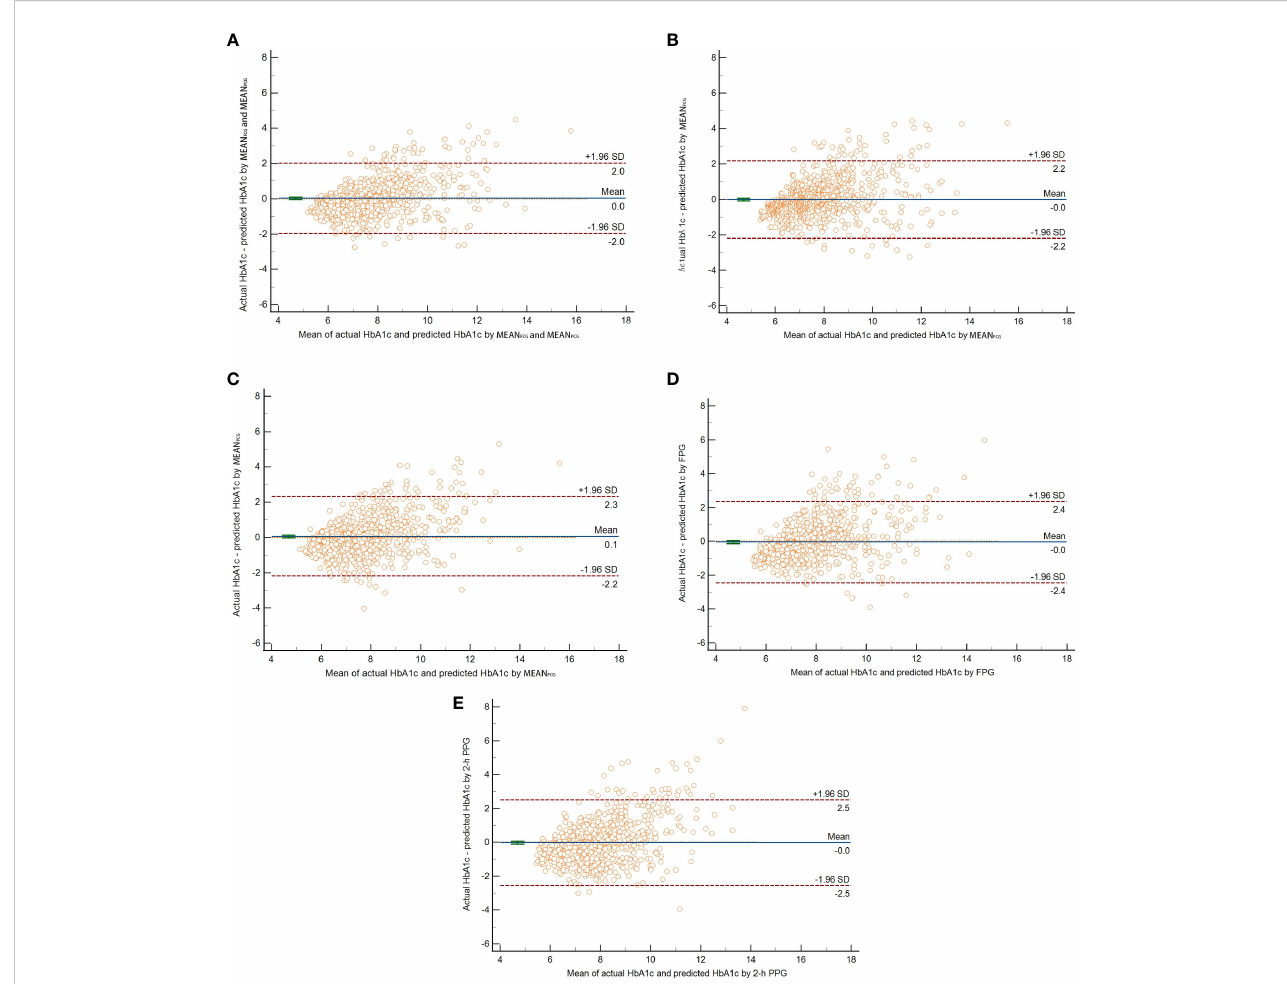
FIGURE 2 The Bland-Altman plot of actual HbA1c and predicted HbA1c by ridge regression with both MEAN FCG and MEAN PCG (A) , linear regression with MEAN FCG (B) , MEAN PCG (C) , FPG (D) , or 2-h PPG (E) respectively. The horizontal solid line in the middle indicated the mean difference between actual HbA1c and predicted HbA1c. The upper and lower horizontal dotted lines indicated the 95% limits of